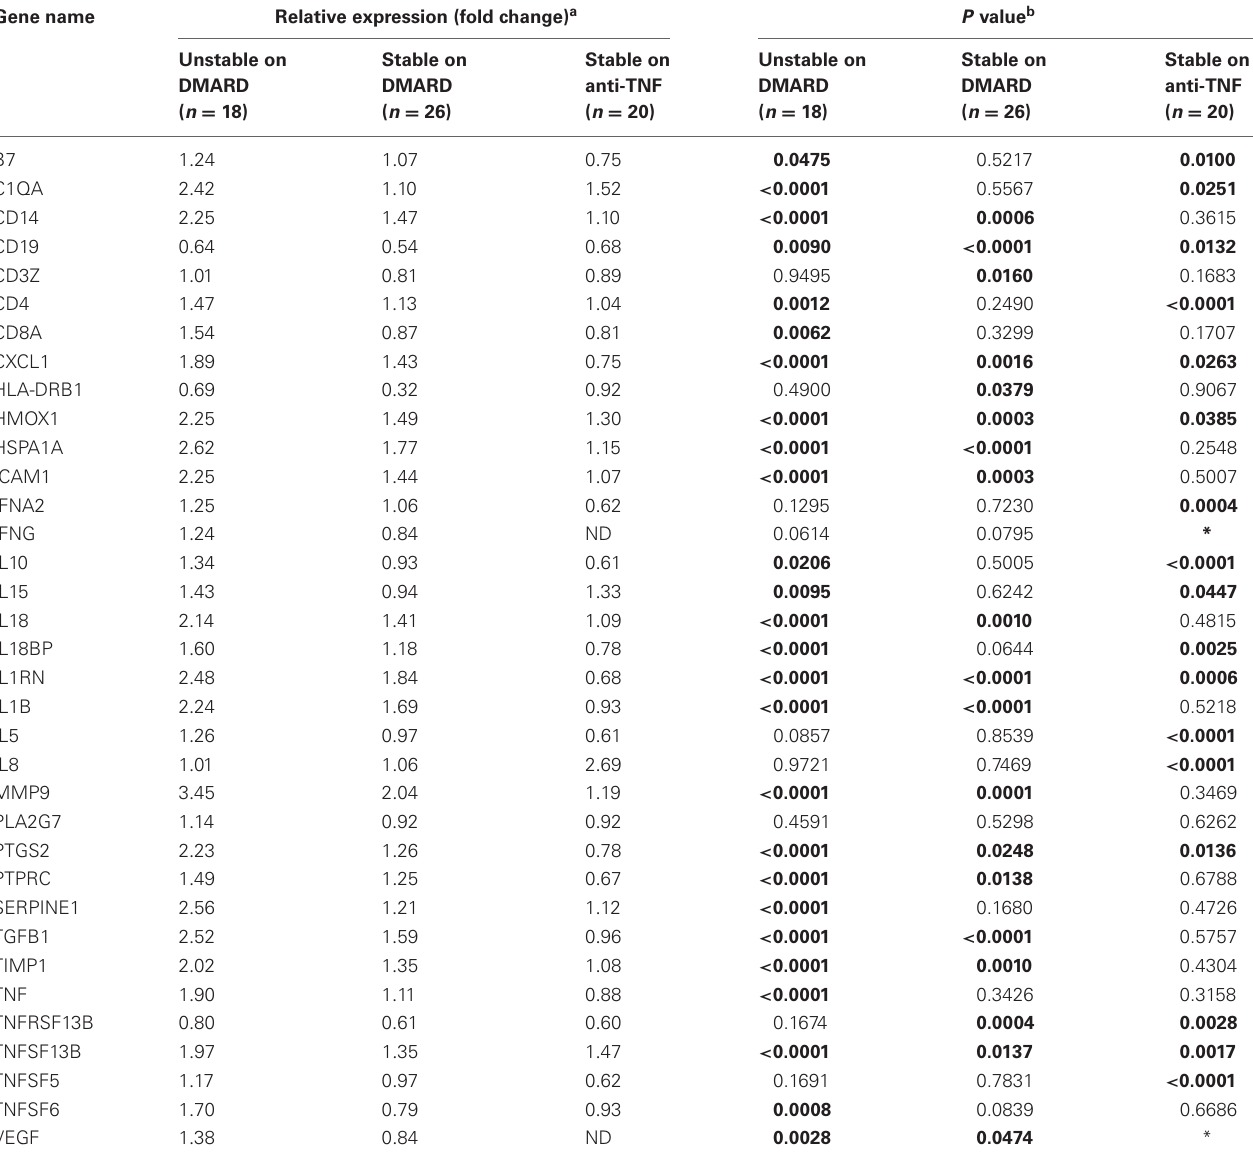
Table 3 | Single time point gene expression analysis in RA patients unstable on DMARD therapy, stable on DMARD therapy, and stable on combination